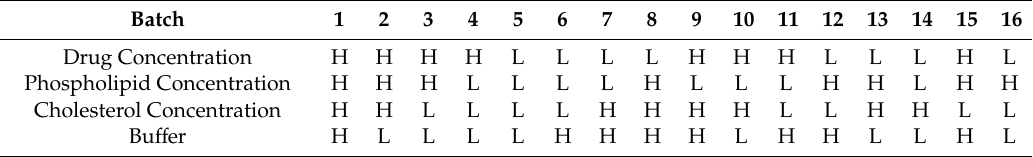
Table 5. Design of experiment (DoE) of material attributes (MA) for phytosome preparation. H and L denote high and low,